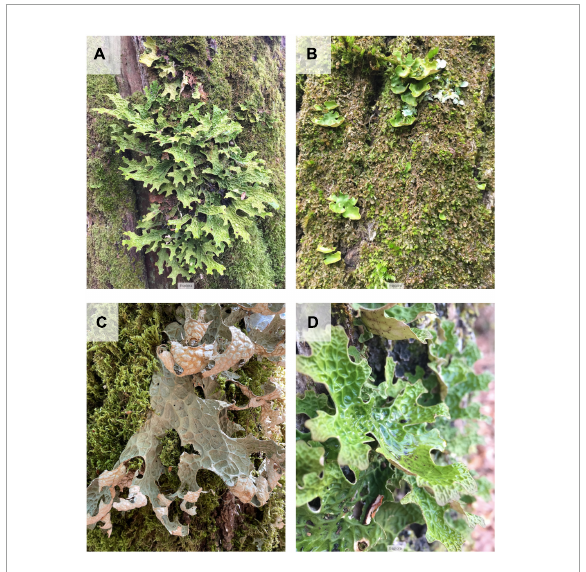
FIGURE1 Life stages of Lobaria pulmonaria as considered in this study: (A) adult thallus with downward growing lobes that tend to overlap leaving an air space between the different levels; (B) juvenile thalli at the beginning of development. The differentiation between ascending and descending lobes is still in the early stages, but the lobes are not yet overlapping; (C) adult thallus in the dehydrated state with convoluted apex of the lobes; (D) detail of an adult thallus in the hydrated state in a natural situation after heavy rain. The accumulation of external water favored by the spoon-shaped conformation of the lobes is